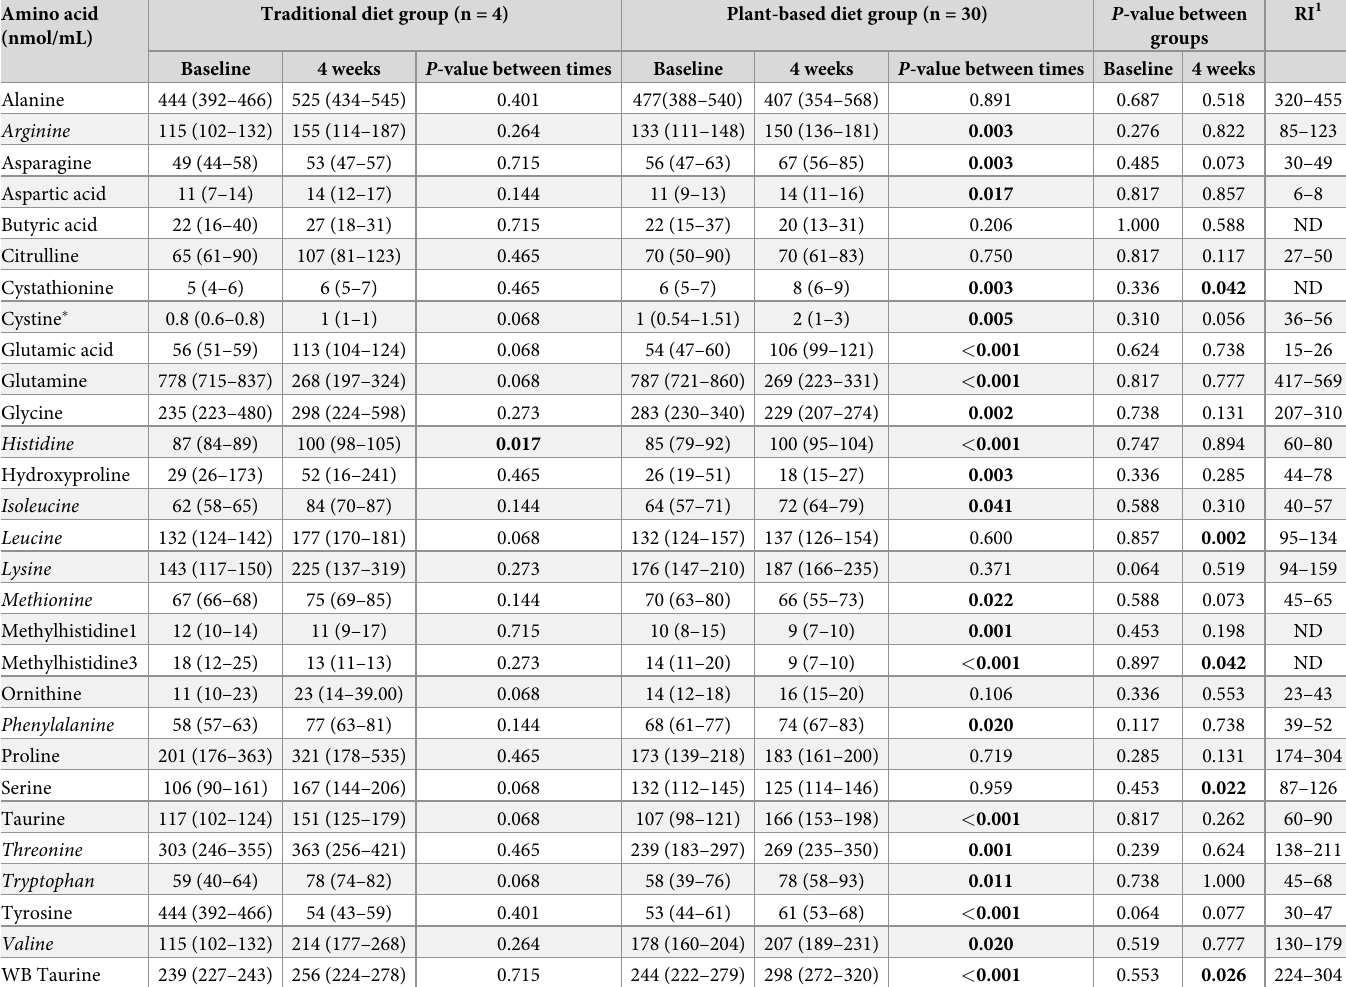
Table 1. Plasma amino acid and whole blood taurine concentrations in dogs fed a traditional diet or a PB diet for 4